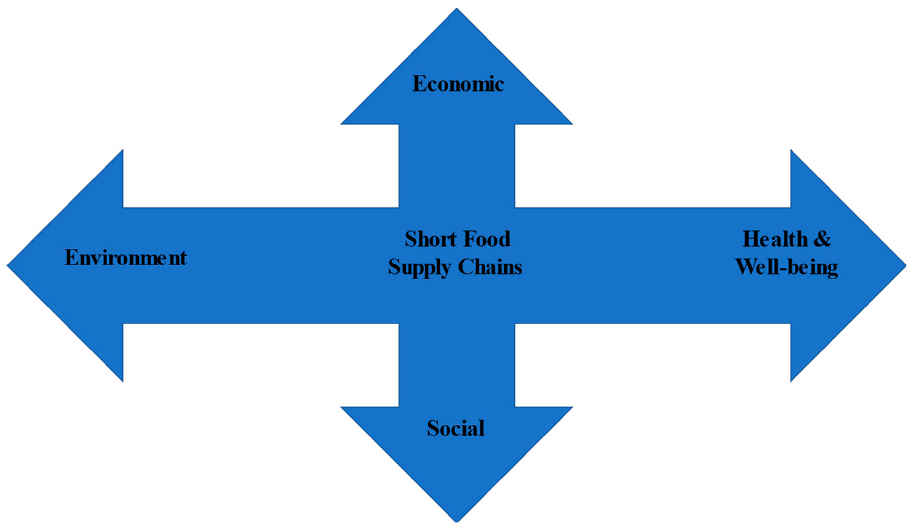
Figure 6. Benefits of short FSCs.